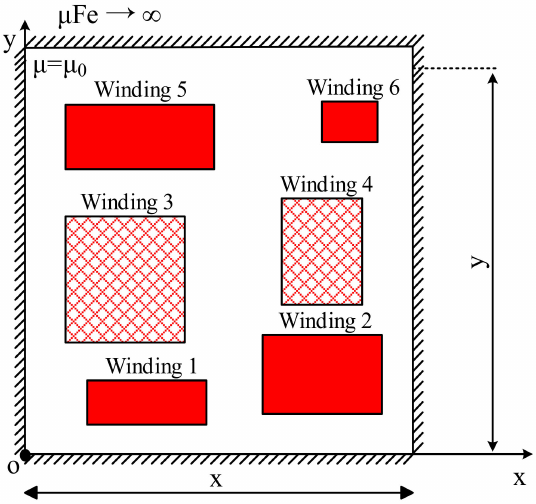
Figure 3. Plane field of the transformer windings.